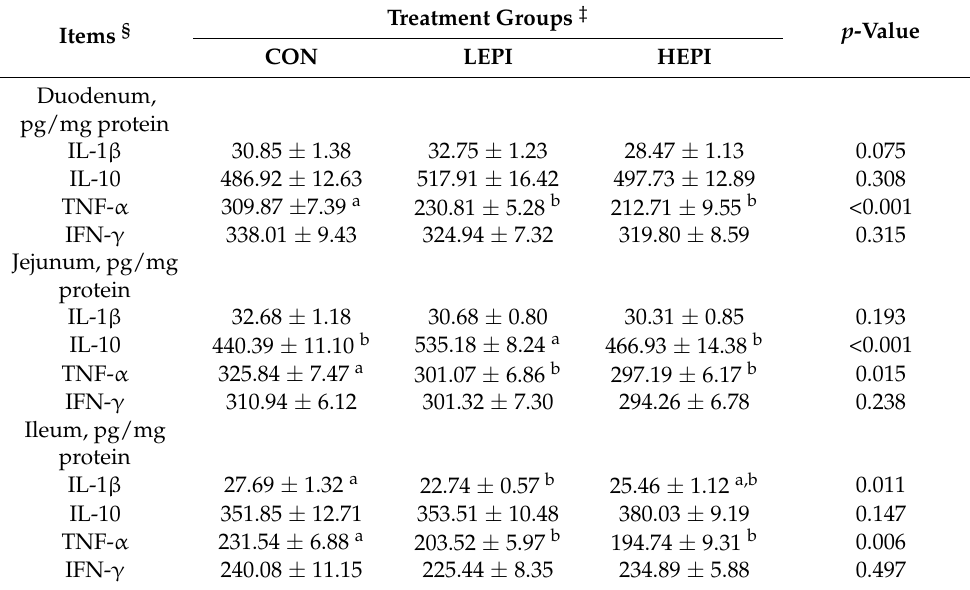
Table 3. Effects of epicatechin on the intestinal cytokine contents of mice †